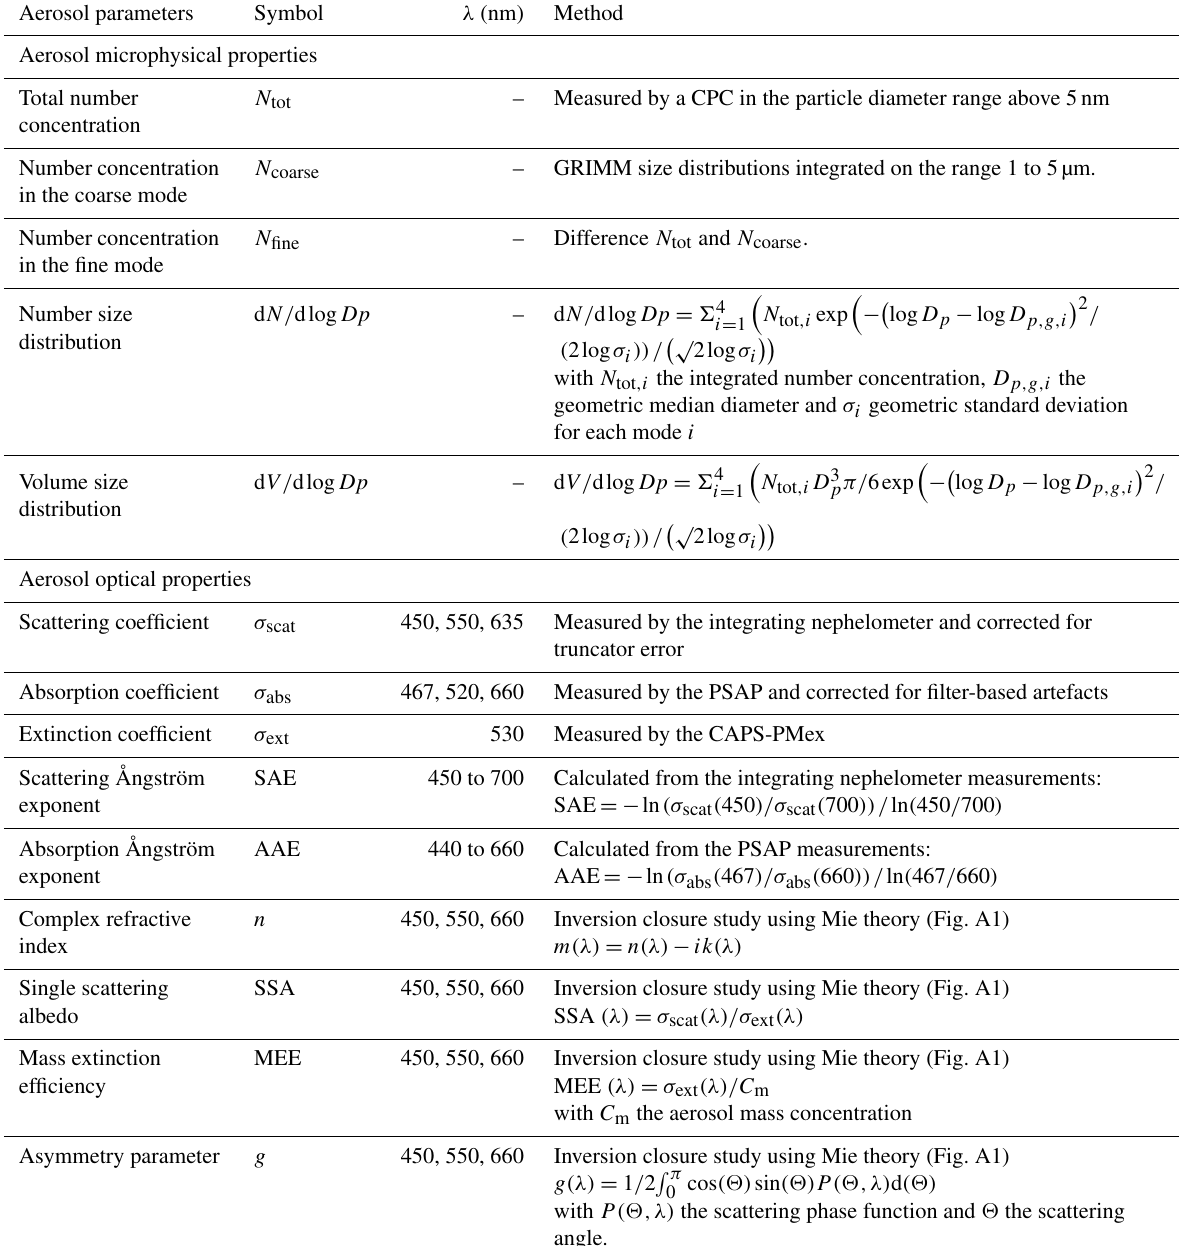
Table 1. Aerosol microphysical and optical properties derived in this work. Aerosol parameters